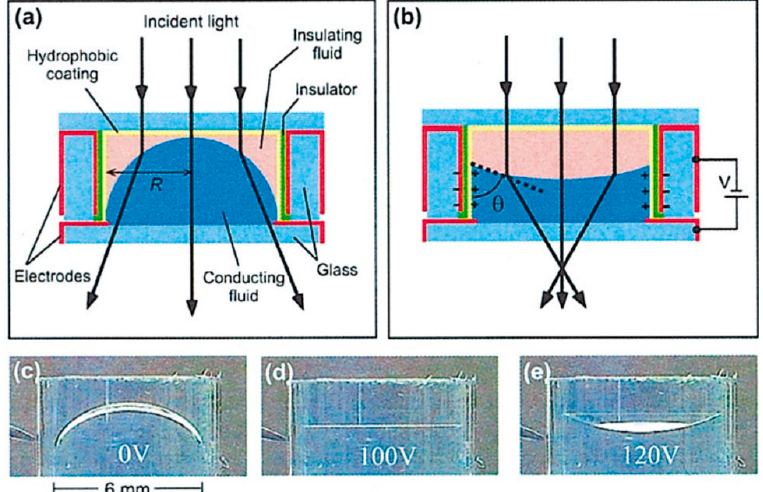
Figure 4. ( a ) Liquid lens system in a cylindrical housing. The red surface denotes conducting electrodes, followed by insulator coating (in green) with further deposition of hydrophobic coating. Conducting